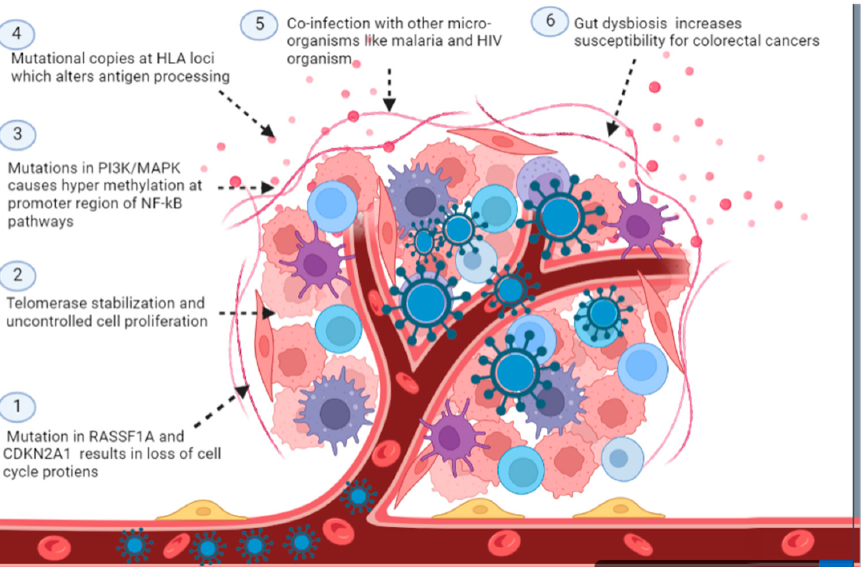
Figure 7. Host factors identified for the transition of normal cells into cancerous used by oncogenic viral products which have a role in the pathogenesis of viral cancers (Image created by bioren- der.com, accessed on 2 November